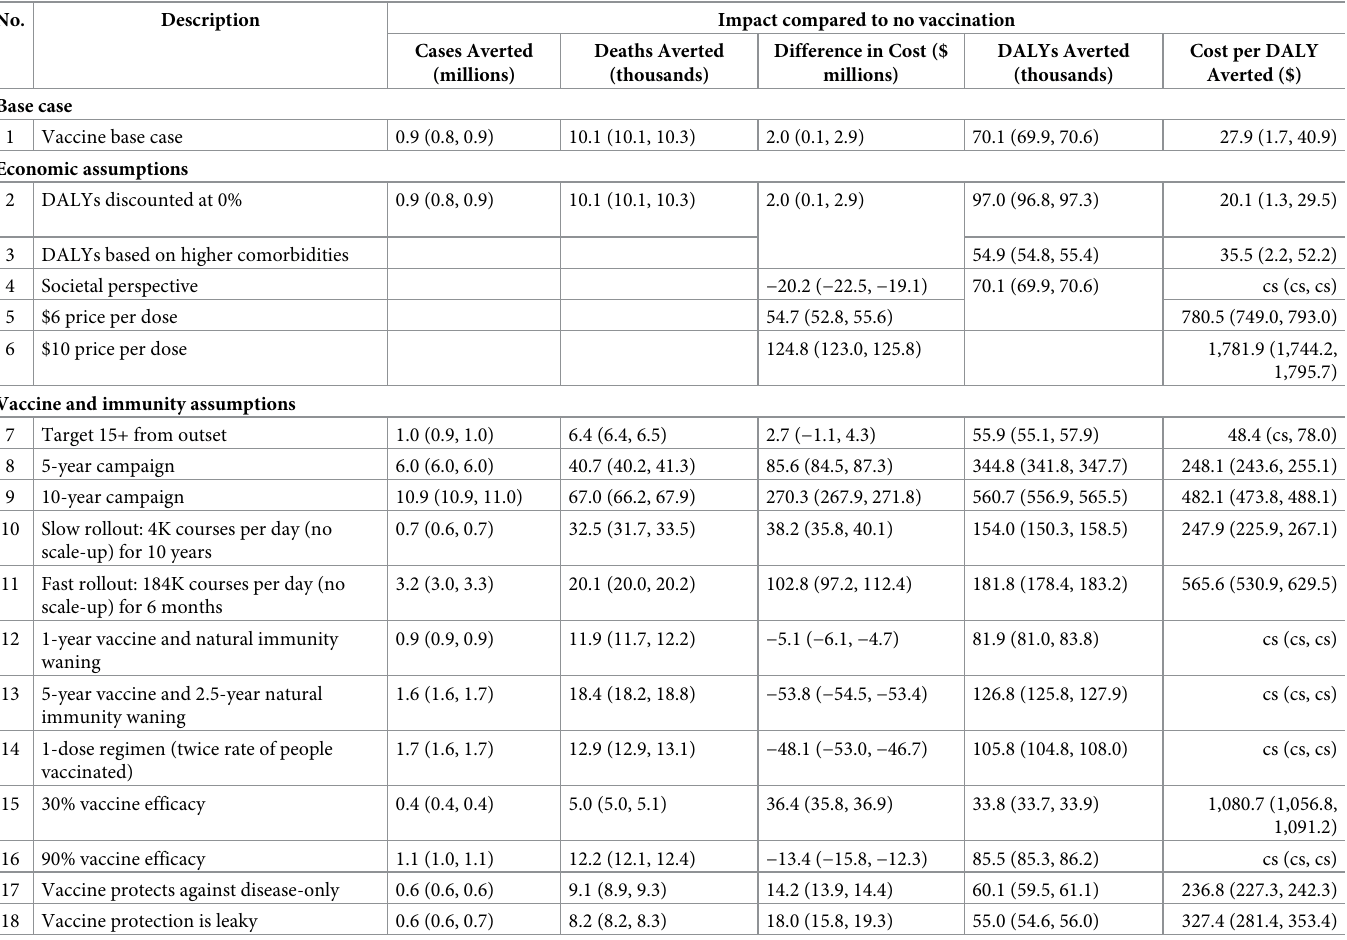
Table 2. Costs in US dollars ($), DALYs averted, cost-effectiveness ratio, cases averted, and deaths averted for different vaccination programme scenarios compared to a counterfactual scenario without vaccination.